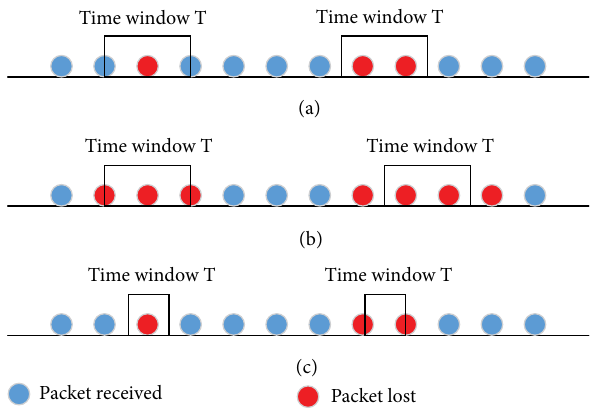
Figure 3: Data communication system reliability